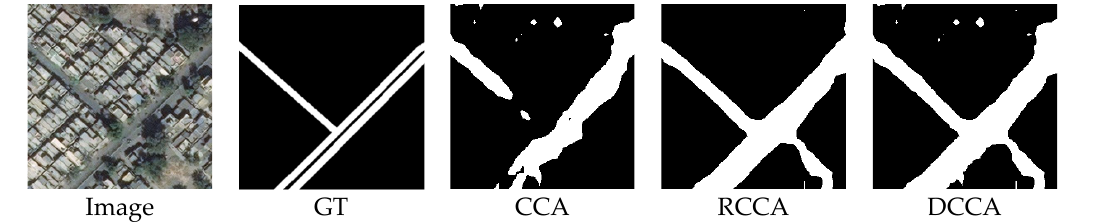
Figure 25. The image, ground truth and the output compilation.